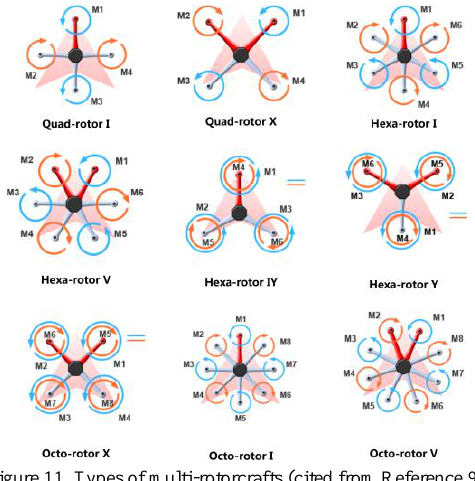
Figure 11 Types of multi-rotorcrafts (cited from Reference 9) 5.1.1